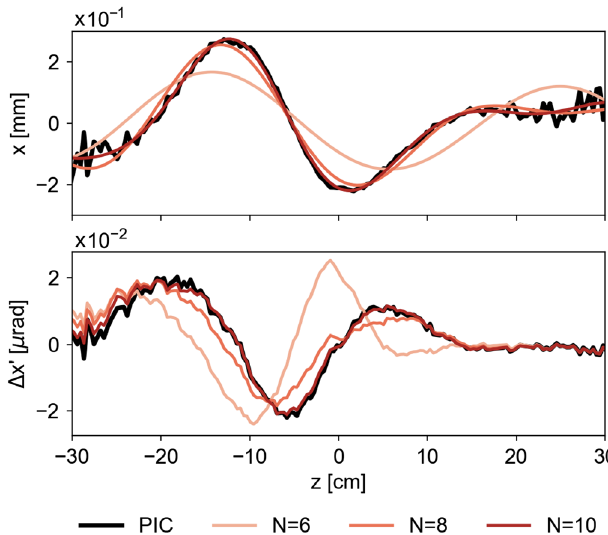
FIG. 5. Top: intrabunch oscillation as observed during an e-cloud instability simulated with the PIC method (black); the other traces show its reconstruction using Eq. (3) with an increasing number of terms. Bottom: transverse kick measured along the bunch in the same PIC simulations (black); the other traces show its reconstruction using Eq.